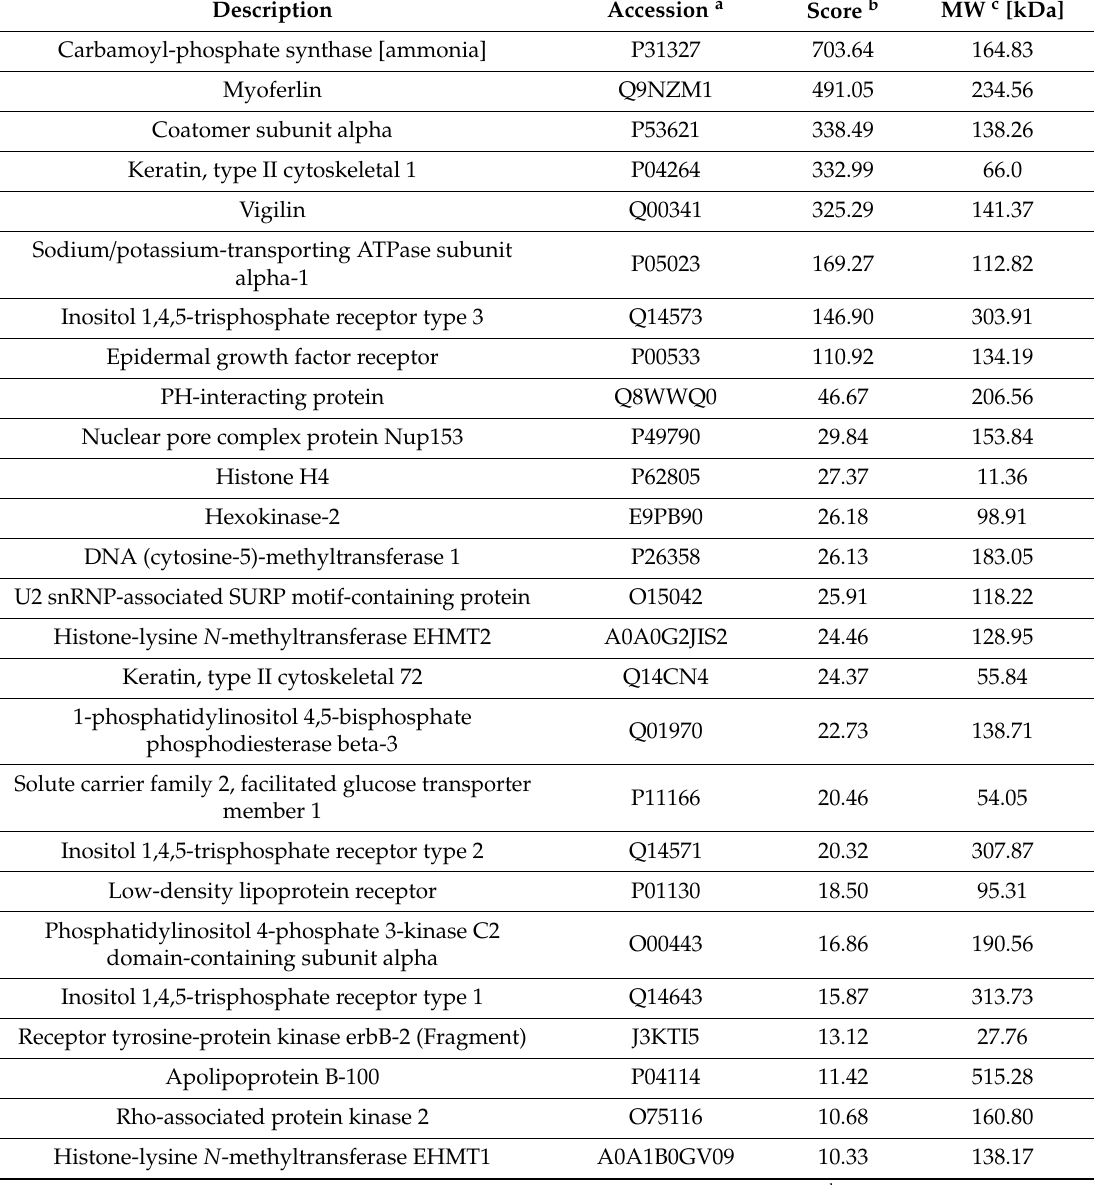
Table 2. Comparative analysis of the protein groups identified by LC-MS /